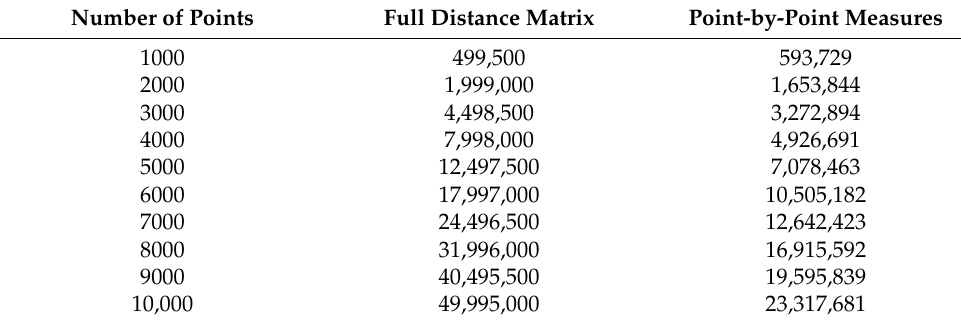
Table 1. Changes of number of calculations according to number of points.